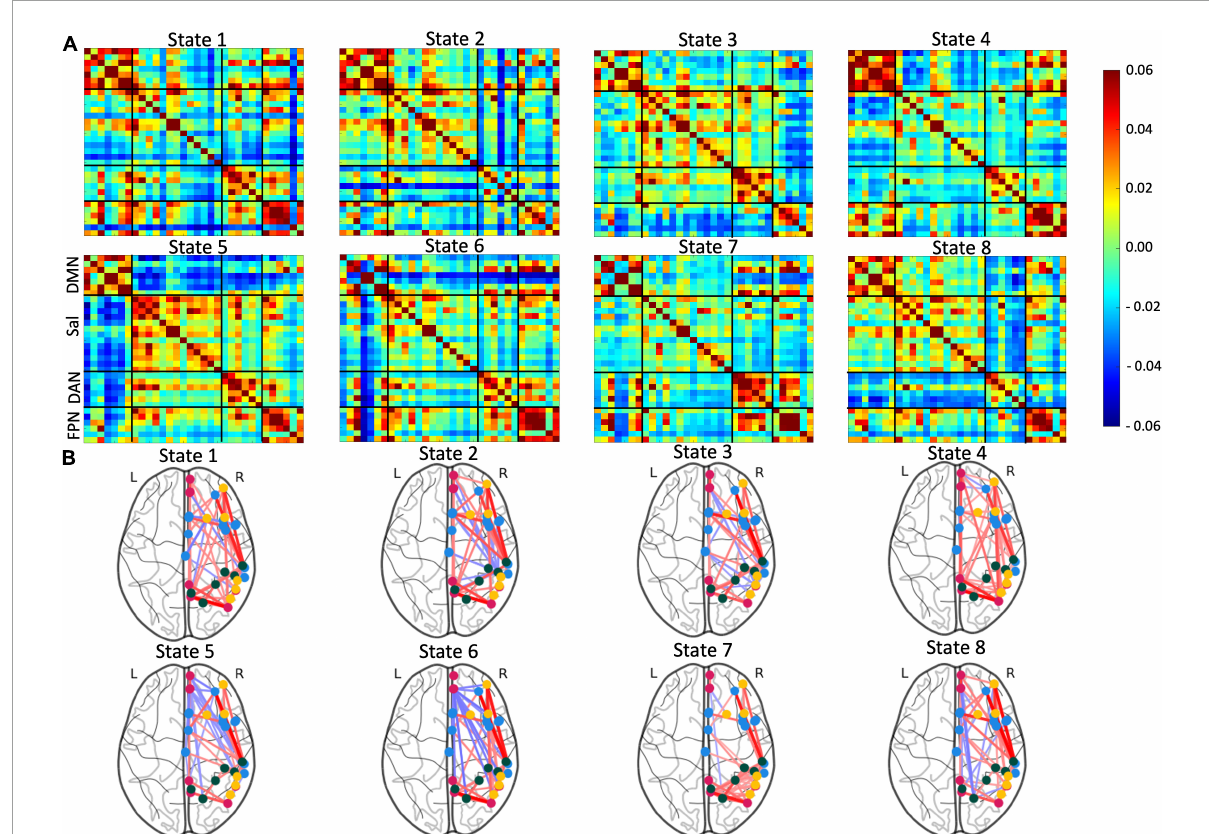
FIGURE2 Visualization of the eight identified brain states. (A) Connectivity matrices of the identified brain states with Fisher Z and L1-normalized correlations. (B) Corresponding glass brain diagrams of the brain states. Red connections indicate positive correlations and blue connections indicate negative correlations. For full, glass brain plots see Supplementary Figure 2 .